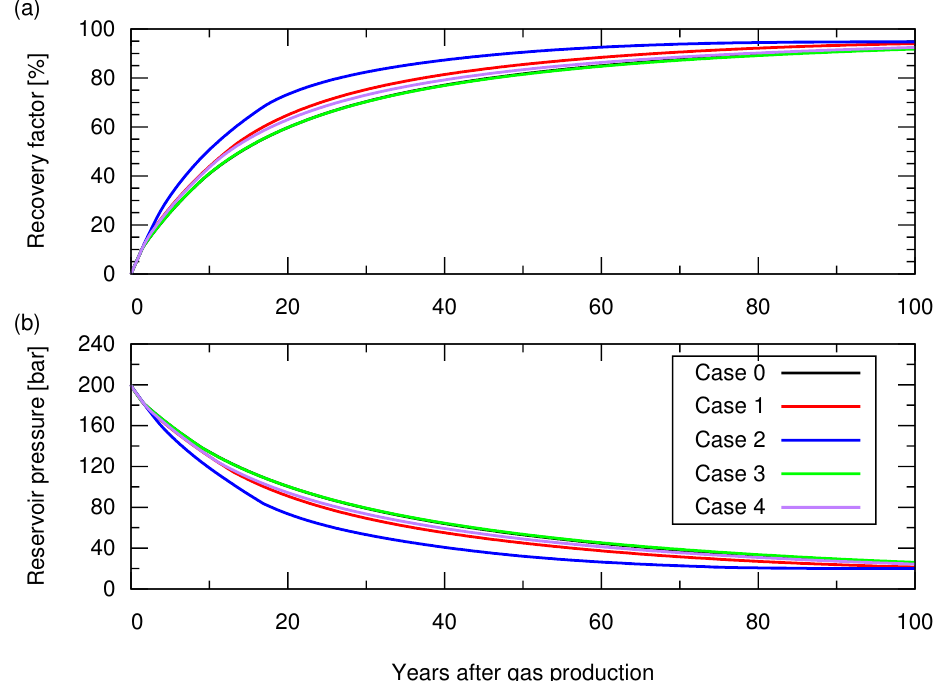
Figure 5. Results of the natural depletion simulations for cases 0 to 4. The descriptions of these cases are shown in Table 1. ( a ) Hydrocarbon gas recovery factor; ( b ) Reservoir